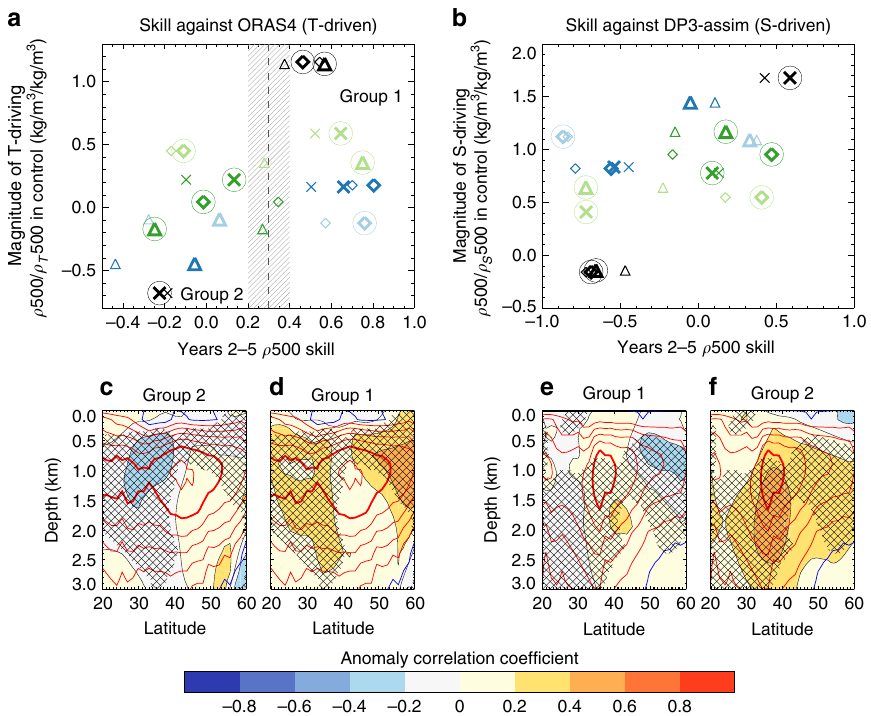
Fig. 4 From Labrador Sea density drivers to large scale circulation. Correlation skill of years 2 to 5 volume averaged Labrador Sea top 500 m density ( ρ 500) in hindcasts assessed against ORAS4 ( a ) and DP3-assim ( b ) plotted against the regression slope between ρ 500 and ρ T 500 ( a ) or ρ 500 and ρ S 500 ( b ) in the control simulations for the same models. The hindcasts are separated into two groups based on a cut-off of r = 0.3 in year 2 to 5 ρ 500 skill, when assessed against ORAS4. The symbol markers are as in Figs. 1 and 2 and the outlying hindcast system bcc-csm1-1 has been excluded from this analysis. The skill for just year 5 is also shown with the same but smaller symbols. The hindcast systems for which streamfunction data was provided are circled in panels a and b . The group average years 2 to 5 Atlantic overturning streamfunction skill assessed against ORAS4 ( c , d ), and DP3-assim ( e , f ), where the groups are as in panels a and b . Group 1: MIROC5, CNRM-CM5, FGOALS-g2, FGOALS-s2 and DePreSys3. Group 2: MPI-ESM-LR, GFDL- CM2p1, IPSL-CM5A-LR, MPI-ESM-MR and MRI-CGCM3. The time mean streamfunctions in the verifying reanalysis are contoured every three Sverdrups (1 × 10 6 m 3 s − 1 ) in red (positive, bold at 15 Sverdrups) and blue (negative). A total of 10 hindcast systems provided streamfunction data and every possible 5-member combination of these is computed to assess the signi fi cance of these group-average skill estimates. The hatching signi fi es skill at the 80% level, i.e., the group mean skill falls in either the top or bottom 10% of possible